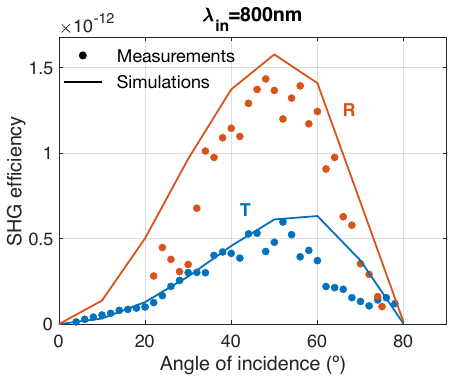
Fig. 2. Transmitted (blue) and reflected (red) measured (full circles) and predicted (solid curves) SHG efficiencies as a function of incident angle from a 25nm-thick amorphous silicon layer when the pump pulse is tuned at 800nm and both harmonic and fundamental fields are TM-polarized.